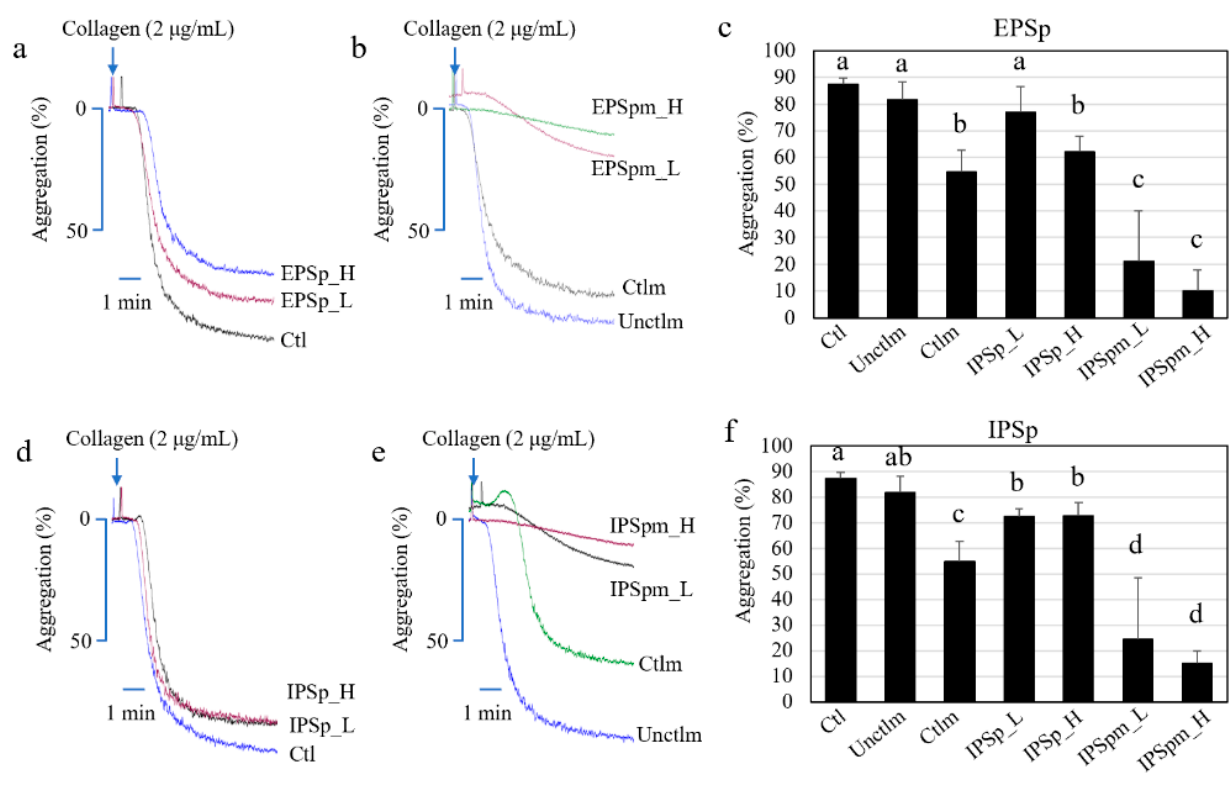
Figure 4. The effects of Cs-4 EPSp, IPSp, and their gut bacterial metabolites on human platelet aggregation induced by collagen. ( a ) EPSp; ( b ) EPSpm; ( c ) bar chart of EPSp and EPSpm; ( d ) IPSp; ( e ) IPSpm; ( f ) bar chart of IPSp and IPSpm. Ctl: phosphate buffered saline; Unctlm: fecal fermentation basal medium before fecal fermentation; Ctlm: fecal fermentation basal medium after fecal fermen- tation; EPSp: purified Cs-4 exopolysaccharides, IPSp: purified Cs-4 intracellular polysaccharides. EPSpm: EPSp after fecal fermentation; IPSpm: IPSp after fecal fermentation. H: 5 mg/mL for EPSp, IPSp, EPSpm and IPSpm; L: 1 mg/mL for EPSp, IPSp, EPSpm and IPSpm. Collagen: 2 μ g/mL. Data